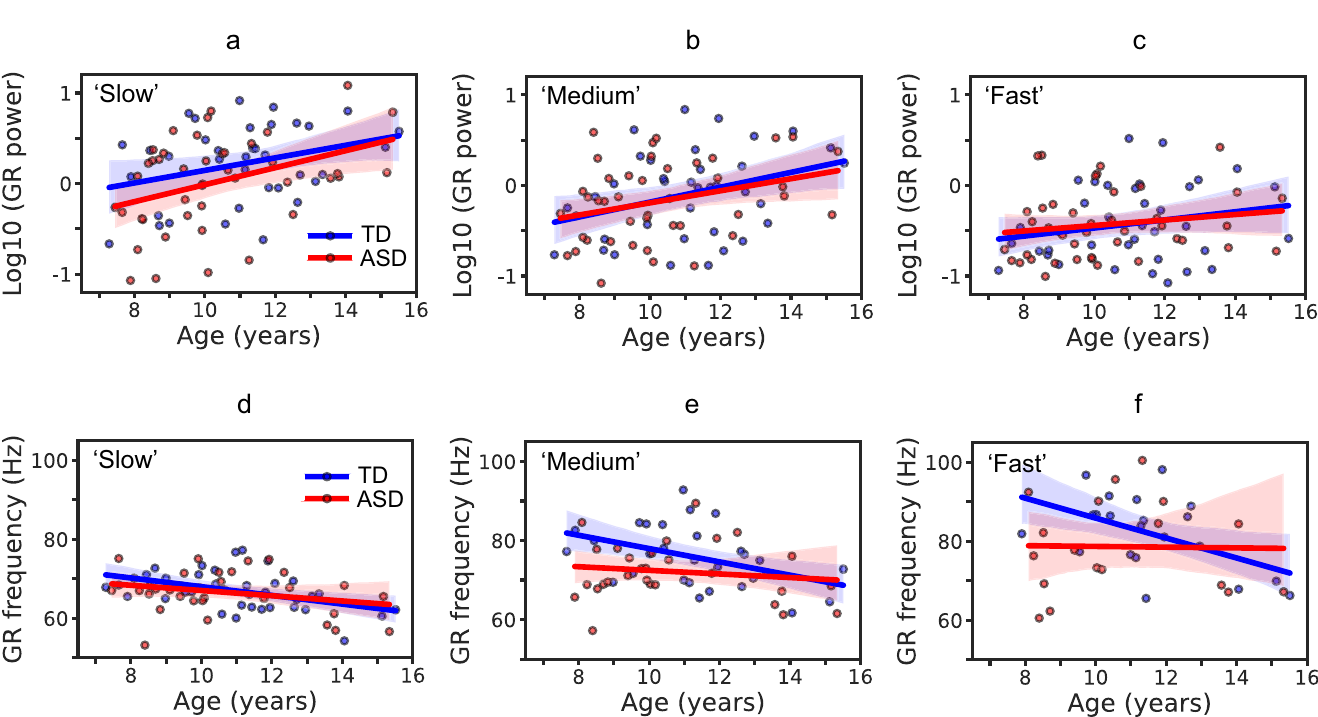
Fig 3. Developmental changes in power (a,b,c) and frequency (d,e,f) of gamma responses (GRs) under ‘slow’ (1.2˚/s), ‘medium’ (3.6˚/s), and ‘fast’ (6.0˚/s) velocity conditions in children with ASD and in TD children. Solid lines show linear fit and the shaded areas correspond to 95% confidence intervals.